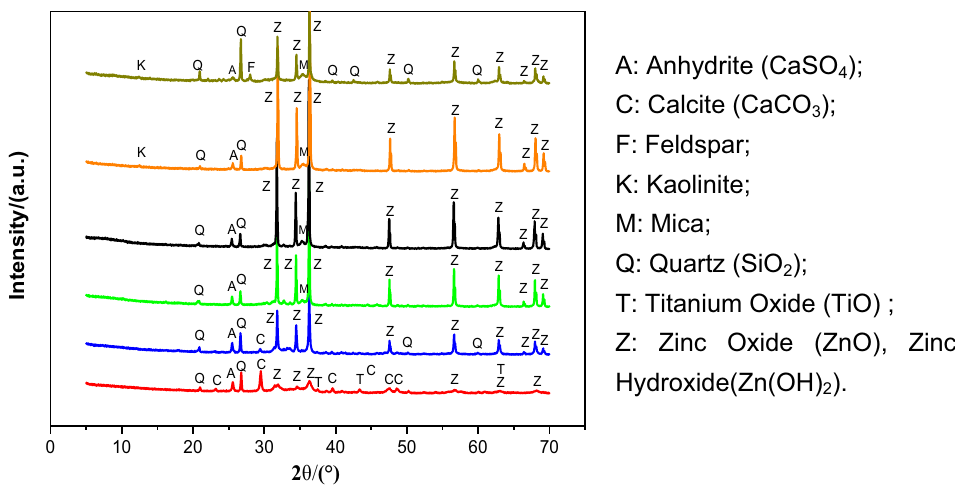
Fig. 2 Ash composition for coals with different densities, the plots from top to bottom was for \ 1.25, 1.25–1.30, 1.30–1.35, 1.35–1.40, 1.40–1.45 and [ 1.45 g/cm 3 , respectively